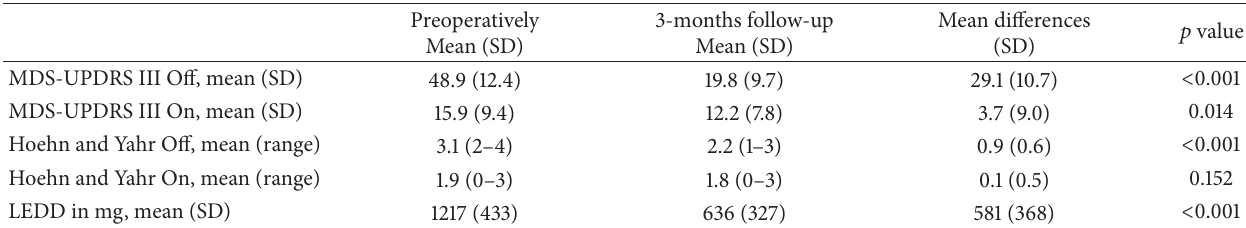
Table 2: Results of neurological measurements; Movement Disorder Society-Sponsored Revision of the Unified Parkinson’s Disease Rating Scale (MDS-UPDRS-III) motor scores, Hoehn and Yahr disease stage, and levodopa equivalent daily dose (LEDD) in mg preoperatively and at 3-month